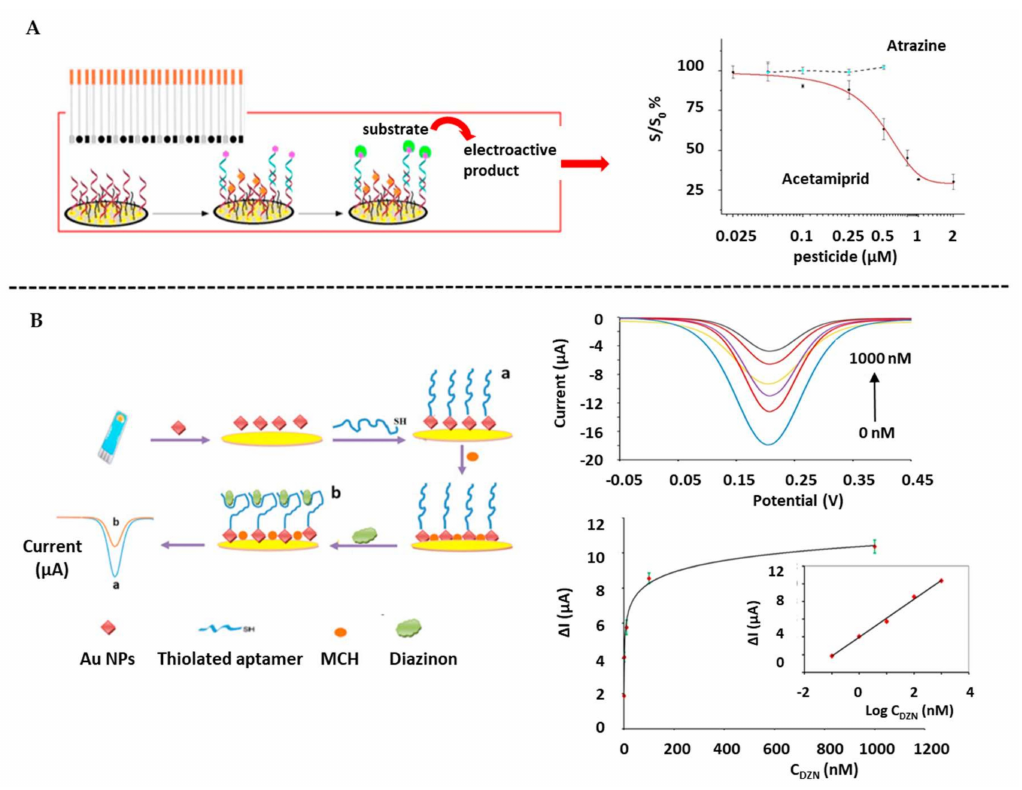
Figure 7. Aptasensors for pesticides determination on screen-printed electrodes: ( A ) Immobilization of aptamer on AuNPs-modified SPGE for the determination of Acetamiprid and the dose-response curve of Acetamiprid and Atrazine. Adapted from [193], Copyright 2016, with permission from Elsevier. ( B ) Immobilization of aptamer on AuNPs-modified gold SPE for Diazinon detection and DPV measurements at di ff erent concentrations together with the calibration curve. Reprinted from [195], Copyright 2018, with permission from